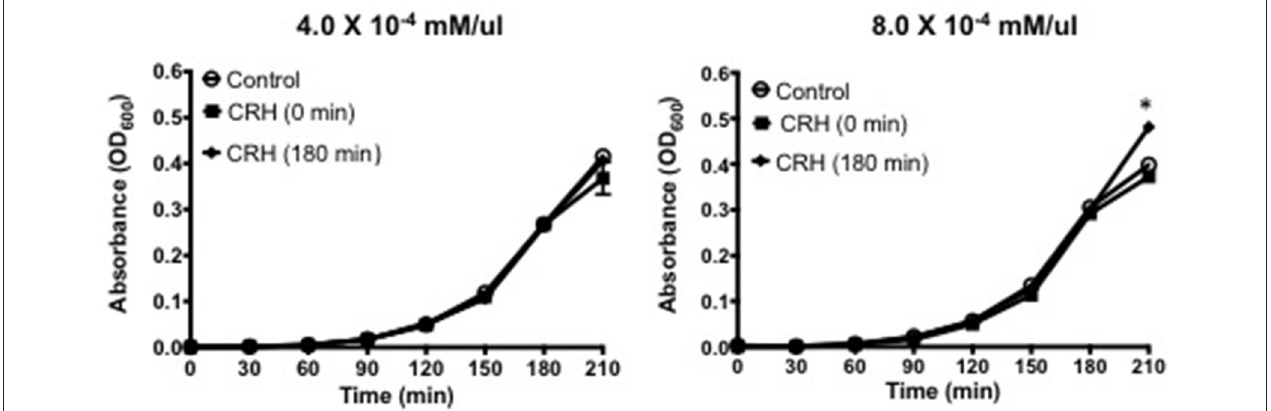
FIGURE 1 | CRH promotes pneumococcal growth at log-phase. Growth curve analysis was performed on Serotype 1 pneumococcal strain in the presence or absence of CRH (4.0 × 10 − 4 and 8.0 × 10 − 4 mM/ µ l). Data represents mean ( n = 3) ± standard deviation between CRH and control. Asterisks (*) indicate significant ( P ≤ 0.05) differences between experimental and control groups.